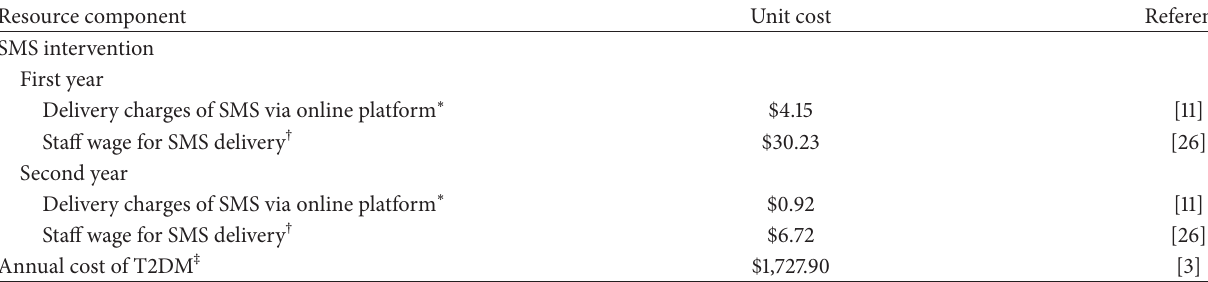
Table 1: Unit costs (US$, year 2011 values) for the SMS intervention.